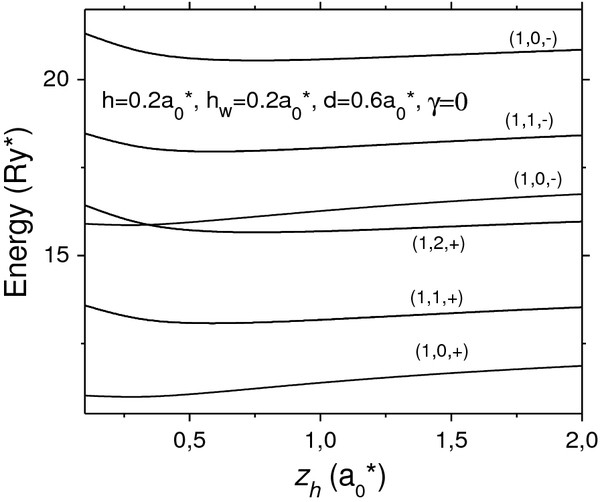
The same as in Figure2 but for disk-shaped QDs.